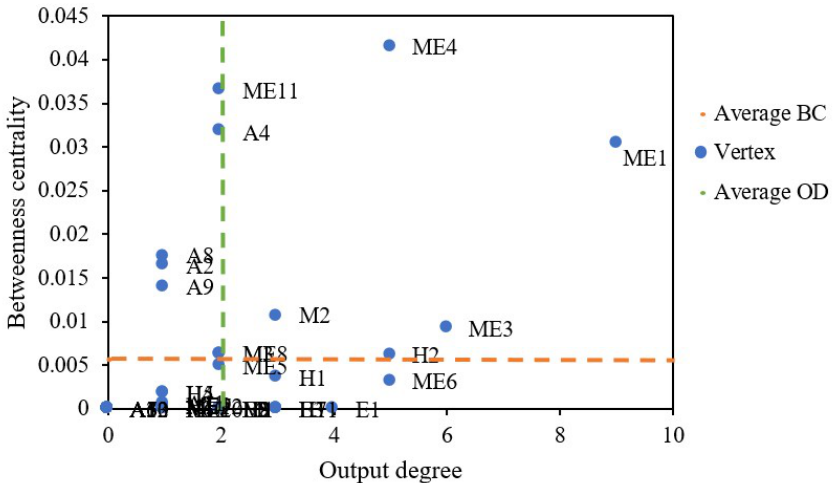
Figure 11. Output degree and betweenness centrality.